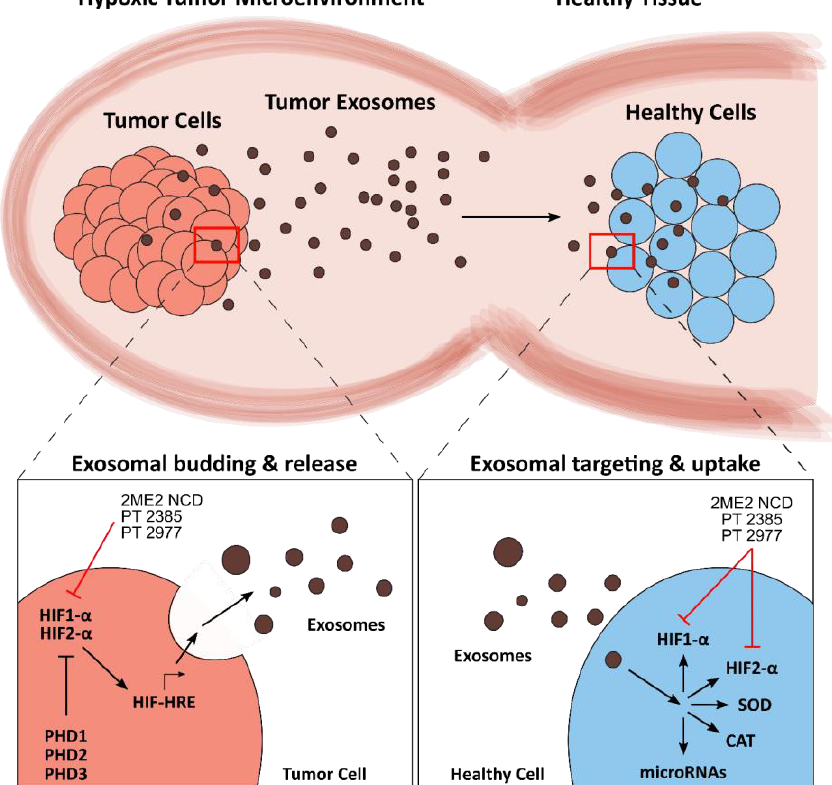
Figure 3. Schematic overview of exosomal modulation of the redox tumor microenvironment (TME). Tumor-derived exosomes maintain and propagate the TME by invading healthy cells (top). Prolyl hydroxylases (PHDs) negatively regulate hypoxia-inducible factors HIF1- α and HIF2- α . Hypoxic conditions activate HIFs, resulting in induction of hypoxia response elements (HREs) and an increase in exosome production (bottom left). The exosomal cargo contains active proteins, such as HIFs, but also microRNAs and RNA transcripts of redox proteins, such as superoxide dismutase (SOD) and catalase (CAT). Exosome uptake leads to the release of this cargo, which alters the redox landscape of the receiving cell (bottom right). The names of pharmaceutical and experimental inhibitors are presented, and the corresponding target sites are indicated by red